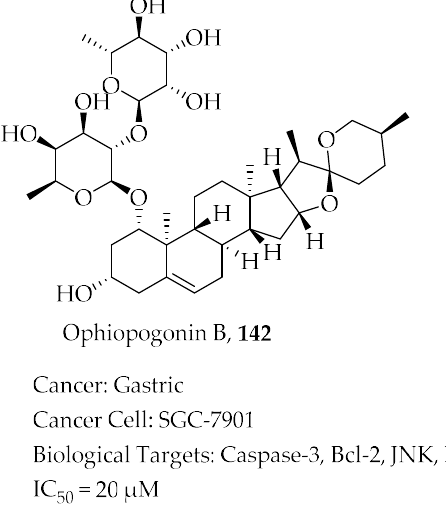
Figure 31. Structure of the saponin Ophiopogonin B with a summary of its biological activity towards selected cancer targets.